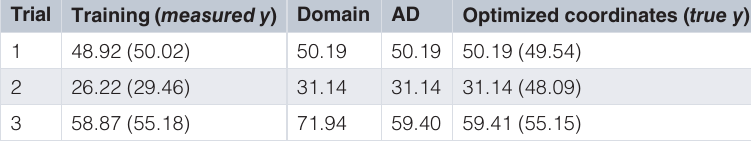
Table 3. Prediction of y values. For each simulation data trial, y values predicted by the SVR model are reported. For training data, the largest measured y value is given in parentheses. “Domain” is defined by x and x with a resolution of 0.005. AD refers 1 2 to the applicability domain of the OCSVM model. For optimized coordinates, the result of the bird function is given in parentheses as the true y value. (i.e., the y value without error).